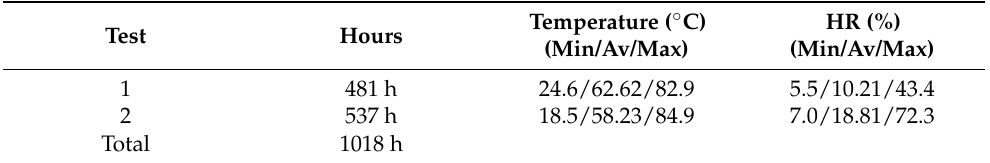
Table 4. Weathering process conditions in Test 1 and Test 2. Minimum (Min), Average (Av) and Maximum (Max) values are